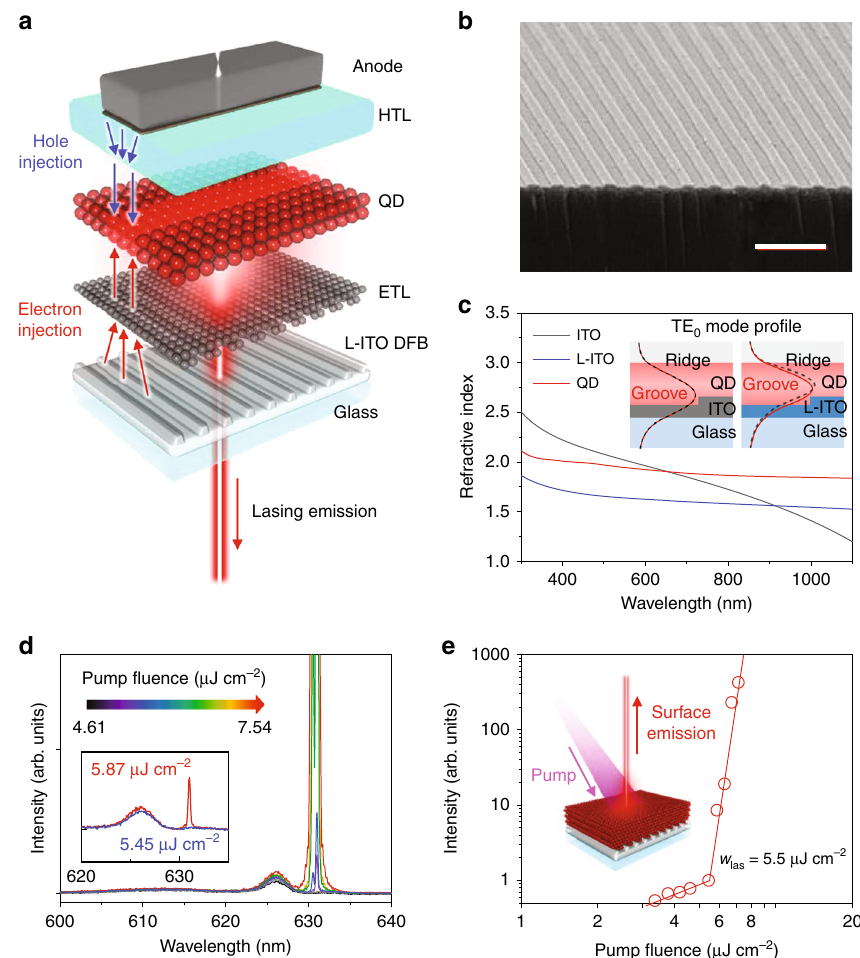
Fig. 1 A QD laser with an L-ITO DFB cavity. a A proposed QLD architecture, which comprises a p-i-n multilayered QD-LED assembled on top of a DFB cavity integrated into a bottom L-ITO electrode. b A scanning electron microscopy (SEM) image of an L-ITO DFB grating with Λ = 370 nm. The scale bar is 1 µ m. c Refractive indices of ITO, L-ITO and close-packed QDs as a function of wavelength. The inset shows calculated TE 0 mode intensity pro fi les at λ = 630 nm across a device stack with a DFB resonator made of either standard ITO (left) or L-ITO (right). The red dashed and black solid lines show mode pro fi les for the groove and the ridge parts of the DFB grating, respectively. The greater difference between these pro fi les in the case of L-ITO compared to standard ITO indicates stronger optical feedback. d Surface emission spectra on the L-ITO-based device as a function of pump fl uence displays a sharp transition to single-mode lasing (at λ = 630.9 nm) at w = 5.5 µ J cm − 2 ; the inset shows emission spectra immediately before (blue) and immediately after (red) the lasing threshold. e Surface emission intensity versus pump fl uence exhibits a well-pronounced threshold behavior with w las = 5.5 µ J cm − 2 . The inset is a schematic of the L-ITO-based lasing device with a QD EML thickness of 200 nm. Source data are provided as a Source Data